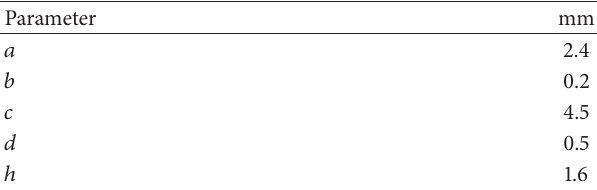
Table 1: Structure dimensions for the EBG unit